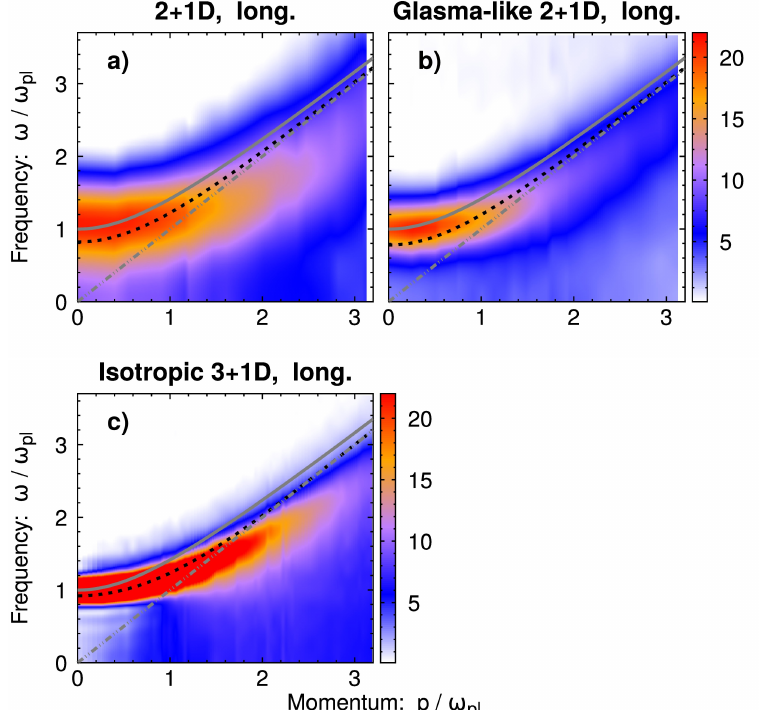
Figure 2 . The normalized longitudinal statistical correlator h EE i L ( t, ω, p ) / h EE i L ( t, ∆ t =0 , p ) is plotted for a) the 2 + 1 dimensional theory, b) for the Glasma-like theory and c) for an isotropic 3 + 1 dimensional system. We also included the HTL dispersion relation ω HTL ( p ) as black dashed L lines, a relativistic dispersion ω ( p ) as a continuous gray curve and the free dispersion ω = p as rel gray dash-dotted